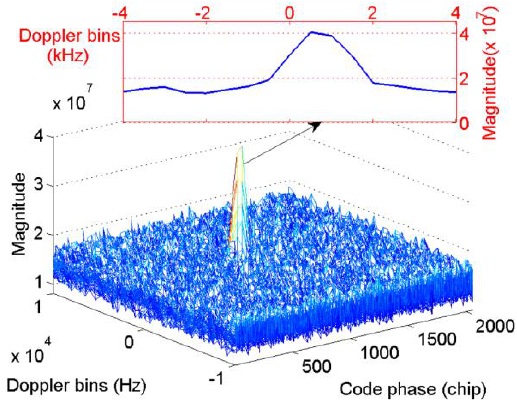
Figure 15. Real data test results of the conventional NC algorithm.